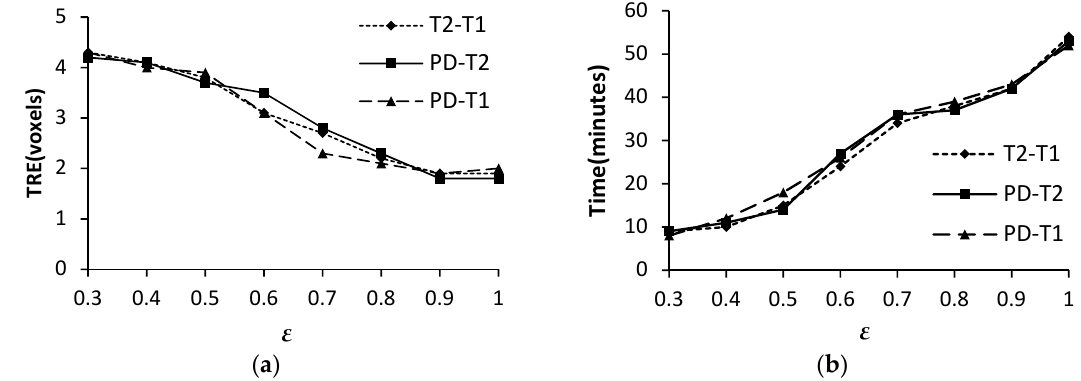
Figure 8. The TRE and computation time with different ε . ( a ) TRE (voxels); and, ( b ) Time (minutes).